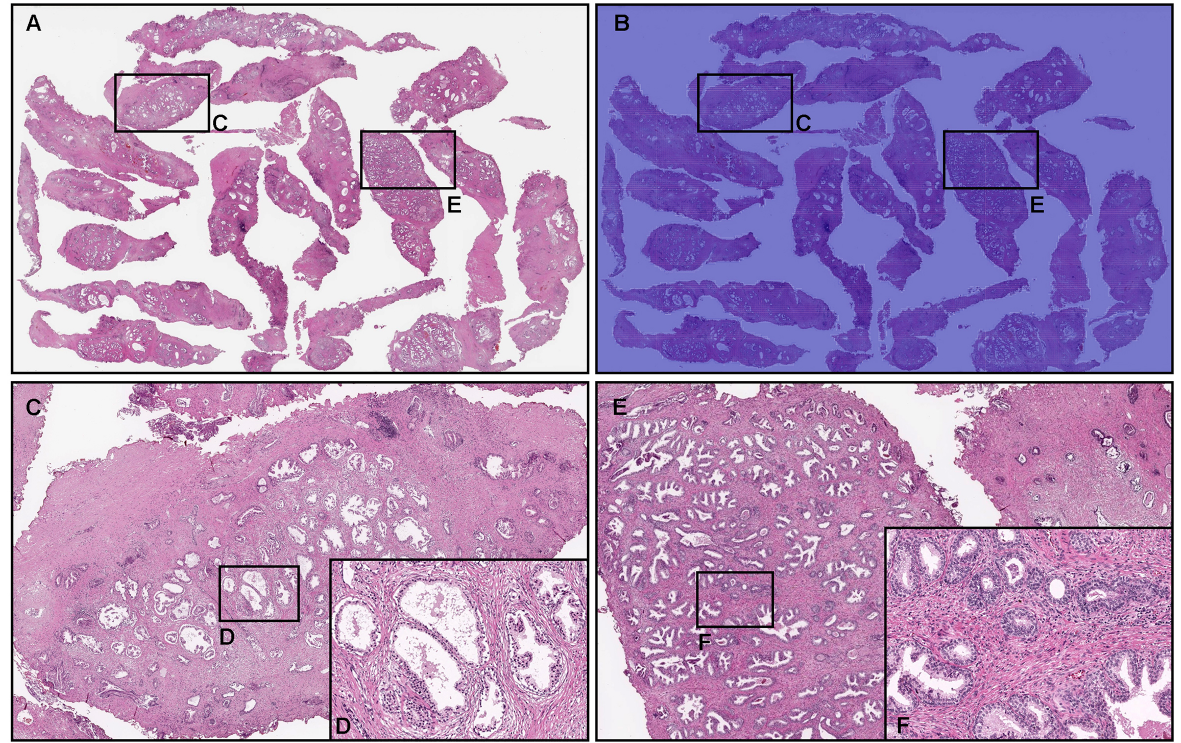
Figure 6. Representative true negative prostate adenocarcinoma prediction outputs on a whole-slide image (WSI) from transurethral resection of the prostate (TUR-P) test sets using the model (TL- colon poorly ADC-2 ( × 20, 512)). Histopathologically, in ( A ), there was nodular hyperplasia (benign prostatic hyperplasia) with chronic inflammation without any evidence of malignancy ( C – F ). The heatmap image ( B , C , E ) shows a true negative prediction of prostate adenocarcinoma. The heatmap uses the jet color map where blue indicates low probability and red indicates high